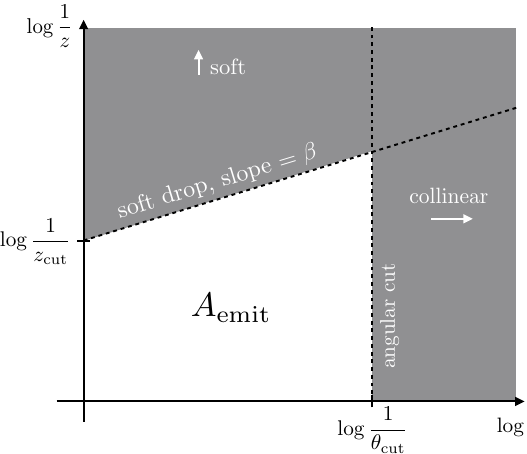
Figure 5. Same as (cid:12)gure 3b, but now highlighting the allowed emission region A counted by soft drop